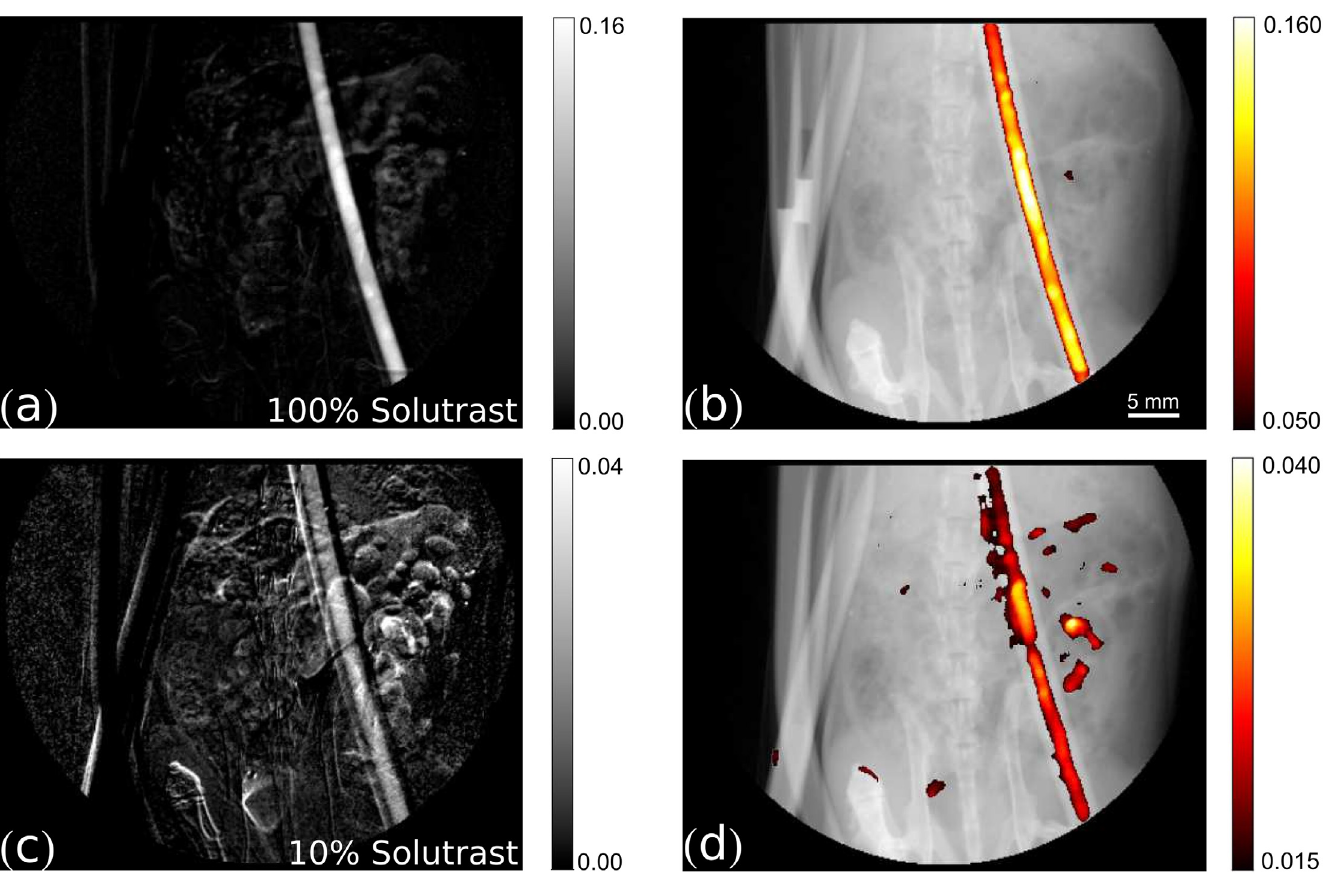
Fig 5. Transmission signal subtraction images. Left column: transmission signal subtraction images. Right column: threshold-limited, filtered superimposition of the transmission subtraction image (in color) on the respective original transmission image (grey values range: [0, 0.9]). (a)-(b) 100% Solutrast, (c)-(d) 10%